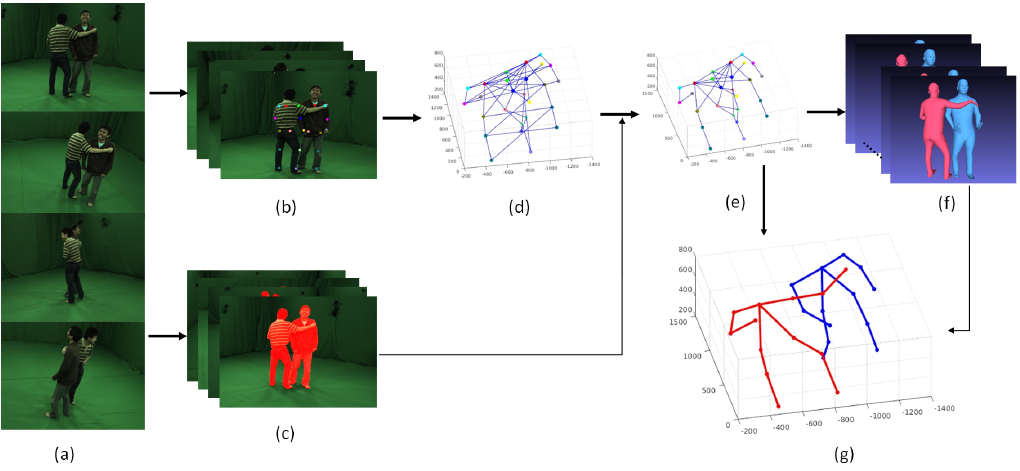
Figure 2. Method Overview. With multi-view images as input ( a ), we first detect the 2D joints ( b ) and human semantic segmentation ( c ) results with learning method in every view image. After triangulating 2D joints to 3D, we could get all 3D pose seeds ( d ) with all connection of semantic neighbor joints. Then we reduce 3D pose seeds number through pre-assembling process ( e ). At last, through pose-assembling optimization, the final 3D poses ( g ) could be obtained combined with SMPL models ( f ) fitting from pre-assembling pose